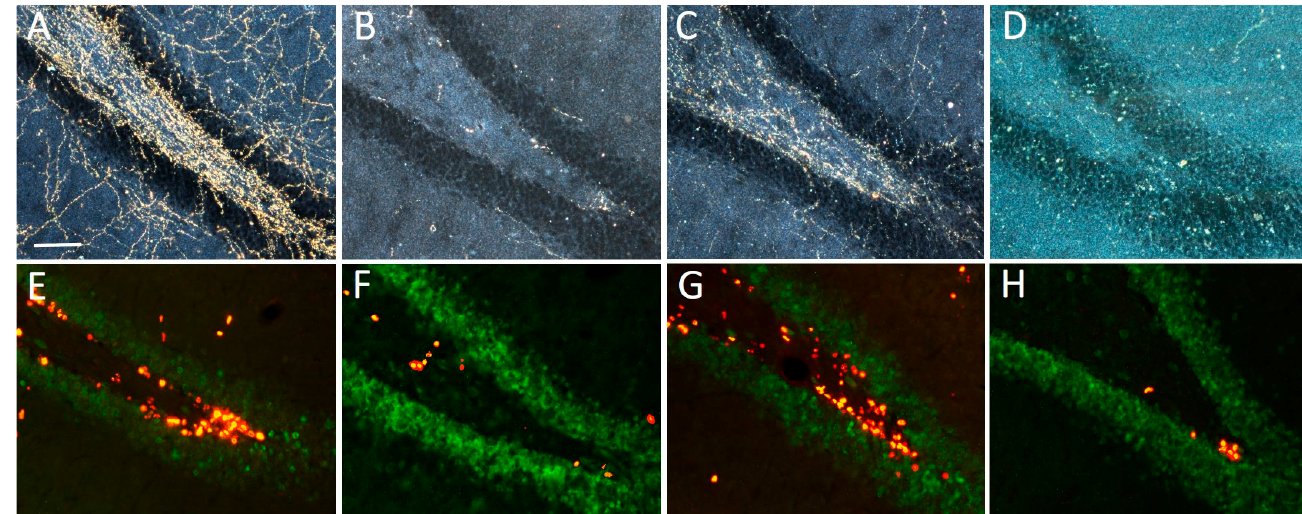
Figure 6. Representative micrographs illustrating DBH-positive innervation ( A – D ) or BrdU (red) and NeuN (green) immunoreactive neurons ( E – H ) in the hippocampal dentate gyrus about 36 weeks after lesioning and grafting. Note the dramatic loss of DBH-immunoreactive fibers and BrdU/NeuN positive progenitors in the Lesioned ( B , F ) and CBL-transplanted animals ( D , H ), compared to Control ( A , E ), which by contrast appeared reinstated in LC-transplanted animals ( C , G ). Scale bar in ( A ): 50 µm.